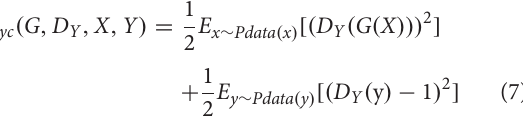
Frontiers in Genetics |